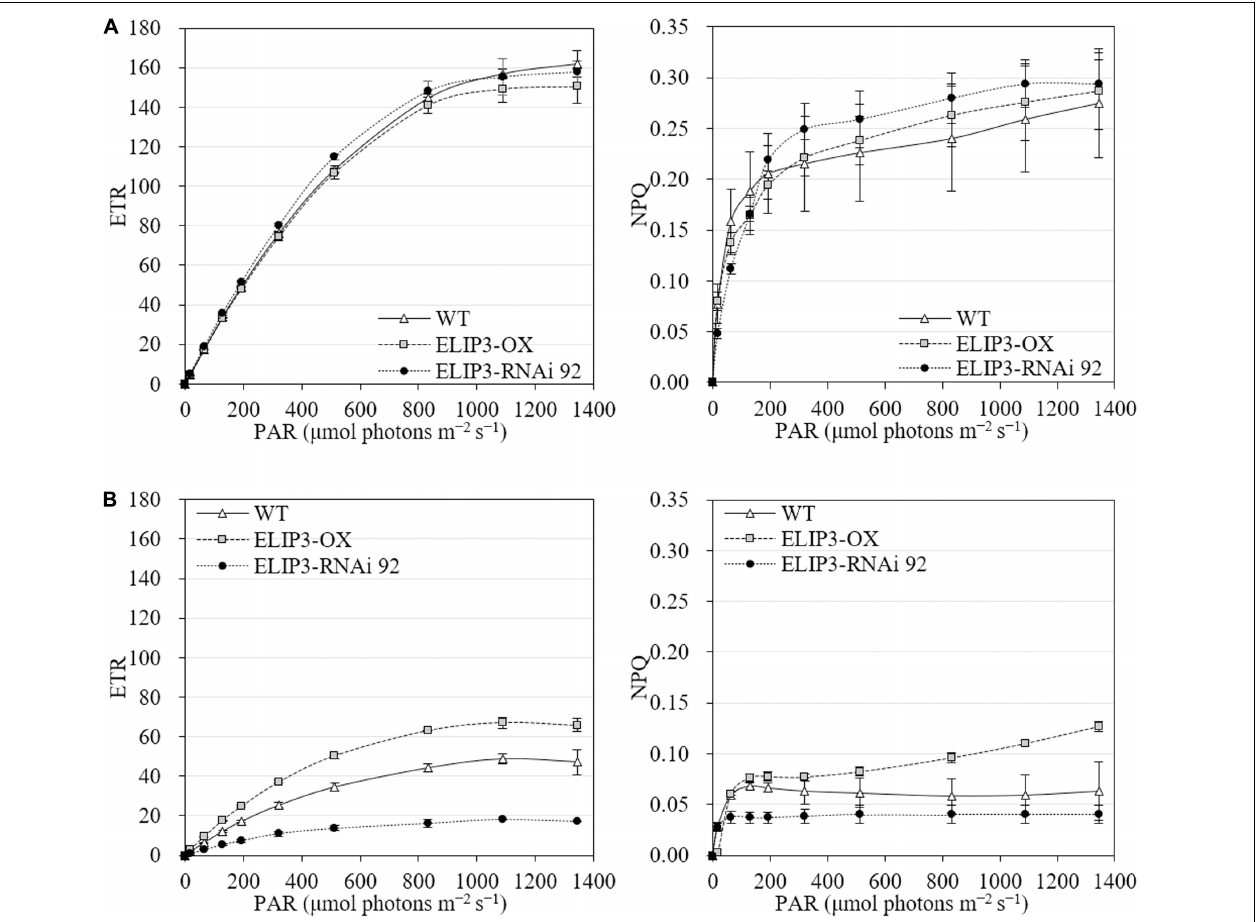
FIGURE 9 | Electron transport rate (ETR) and non-photochemical quenching (NPQ) at different light levels for WT, overexpression strain (OX) and knockdown strain (RNAi 92). (A) 23 ◦ C. (B) 4 ◦ C. The values were measured after 12 h in each condition. Values represent the mean ± SD ( n =